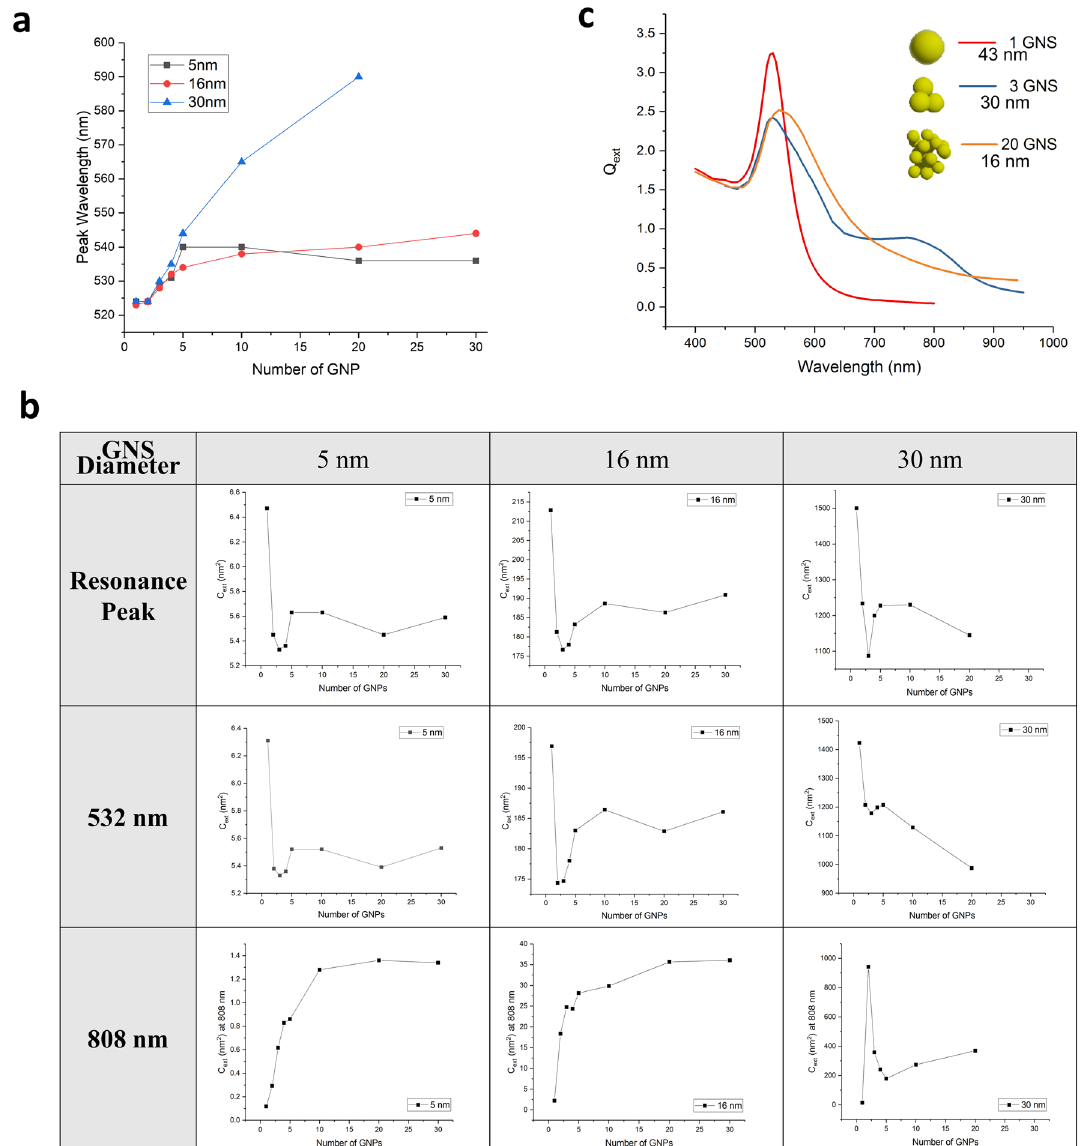
Figure 2. ( a ) Plasmon resonance peak of aggregated GNP. The larger the aggregation size and the larger the GNP diameter, the more red shifted the aggregated cluster will be. ( b ) Averaged per-particle extinction cross-section plots of 5, 16, and 30 nm diameter GNP aggregations at the resonance peak (532 nm (green laser heating) and 808 nm (NIR laser heating)). ( c ) To explore the way to generate the most heat by the same amount of gold, the extinction coefficient (Q ext ) of 1, 3, and 20 particle clusters with very close effective radius (< 1% difference) are compared. We can see the single GNP has the highest extinction at resonance peak, while an aggregation cluster with larger number of GNP is slightly better than the small